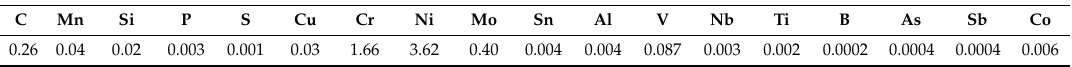
Table 1. Chemical composition in weight percent of the investigated superclean steel.